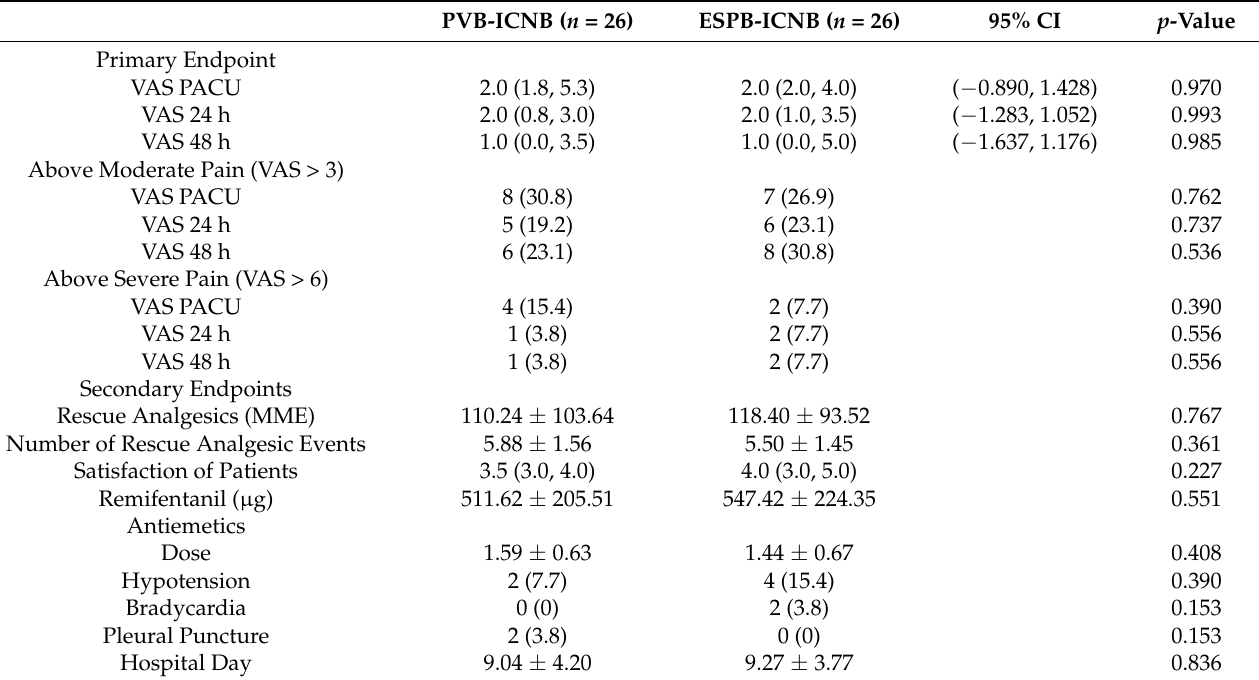
Figure 1. Visual analog scale (VAS) and satisfaction of patients: ( a ) VAS at PACU; ( b ) VAS at 24 h postoperatively; ( c ) VAS at 48 h postoperatively; ( d ) Satisfaction scores of patients. PACU: postanesthetic care unit, PVB: paravertebral block, ESPB: erector spinae plane block, ICNB: intercostal nerve block. Table 2. Outcome